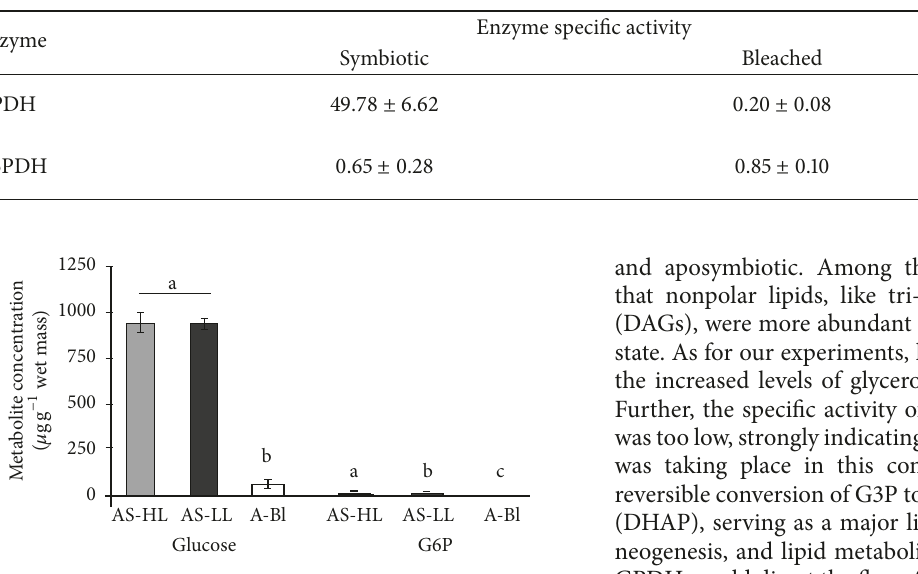
Figure 2: Glucose levels measured in symbiotic and bleached anemones. Animals in the symbiotic state were maintained at two light conditions (HL = 250 𝜇 mol photons cm −2 s −1 ; LL = 50 𝜇 mol photons cm −2 s −1 ). Bleached animals were maintained in the dark. Columnsrepresenttheaverageofthreeindependentdeterminations ± SD (bars). Values are in 𝜇 g g −1 of wet mass. Small letters group treatments that were similar for each metabolite (Tukey HSD, 𝑝 < 0.01 ). AS = symbiotic anemones; A-Bl = bleached